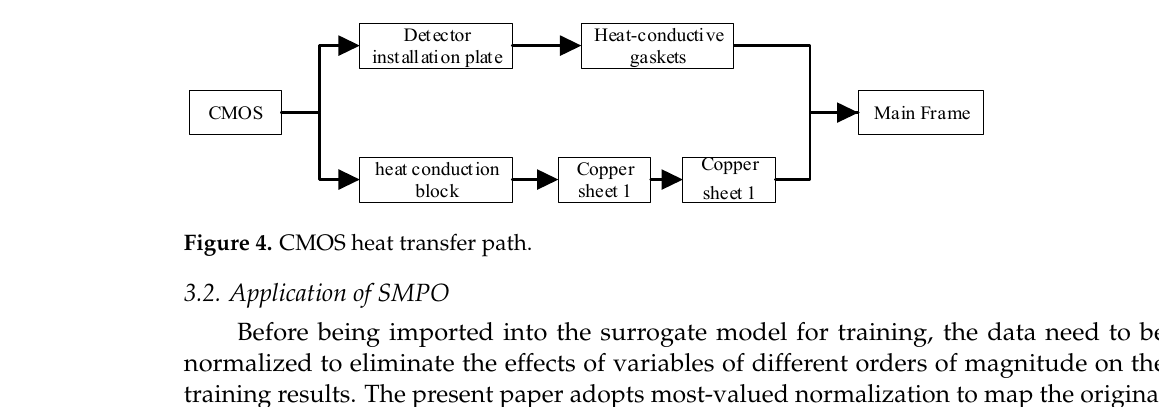
Table 3. Parameters to be optimized.